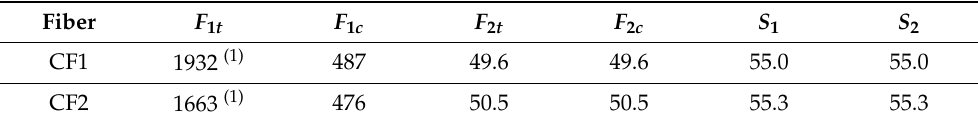
Table 6. Orthotropic strength properties of